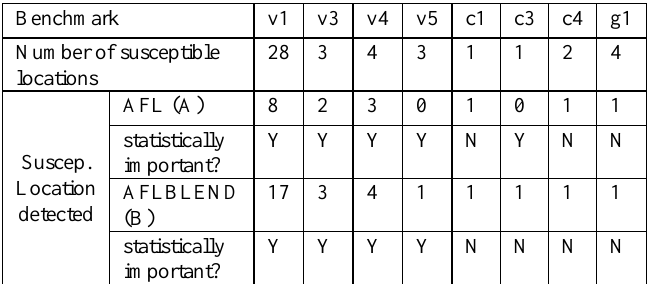
Table 1. Mean value of buffer overrun violations perceived by every tool and results of statistical important